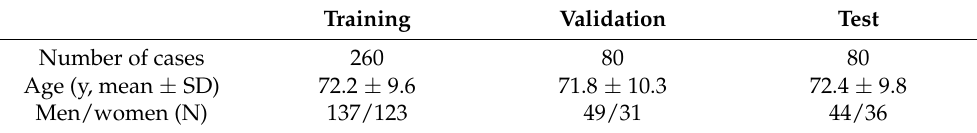
Table 1. Patient characteristics.